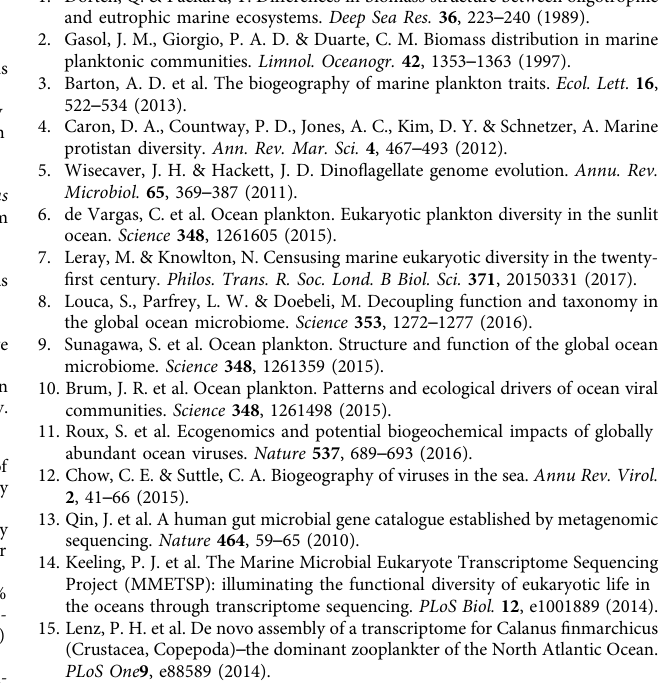
Fig. 3 were obtained using the R package FactoMineR v 1.32, world maps with maps (v 3.1), phylogenetic trees with ggtree (v 1.6.11), and graph representation Fig. 5a and Supplementary Fig. 8a,e with igraph (v 1.0.1) and ggnetwork (v